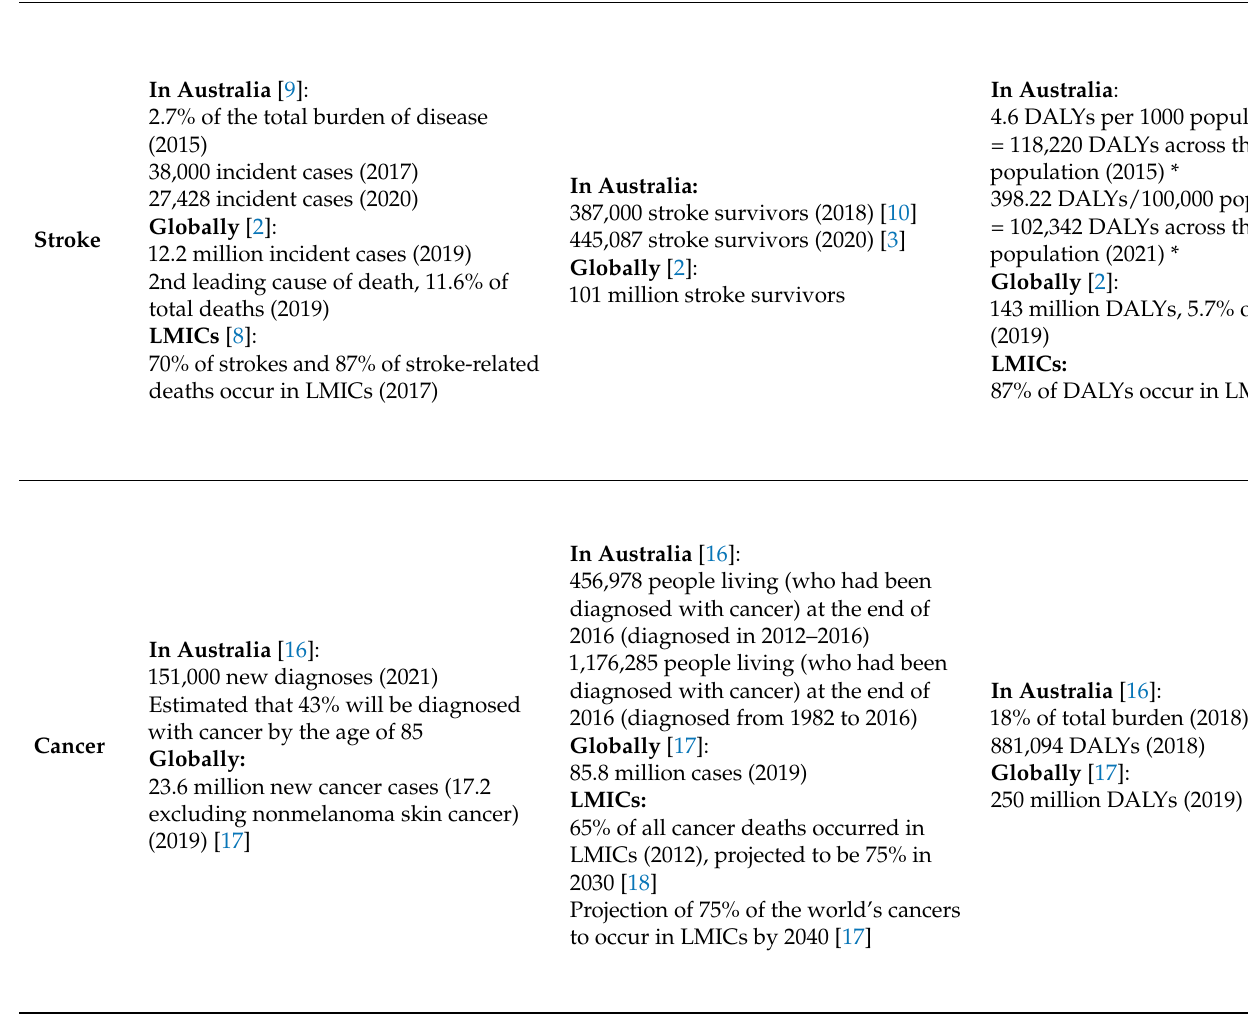
Table 1. Stroke in Cancer stratified by the burden of disease, prevalence, DALYs, and financial burden. Burden of Disease Prevalence DALY Financial